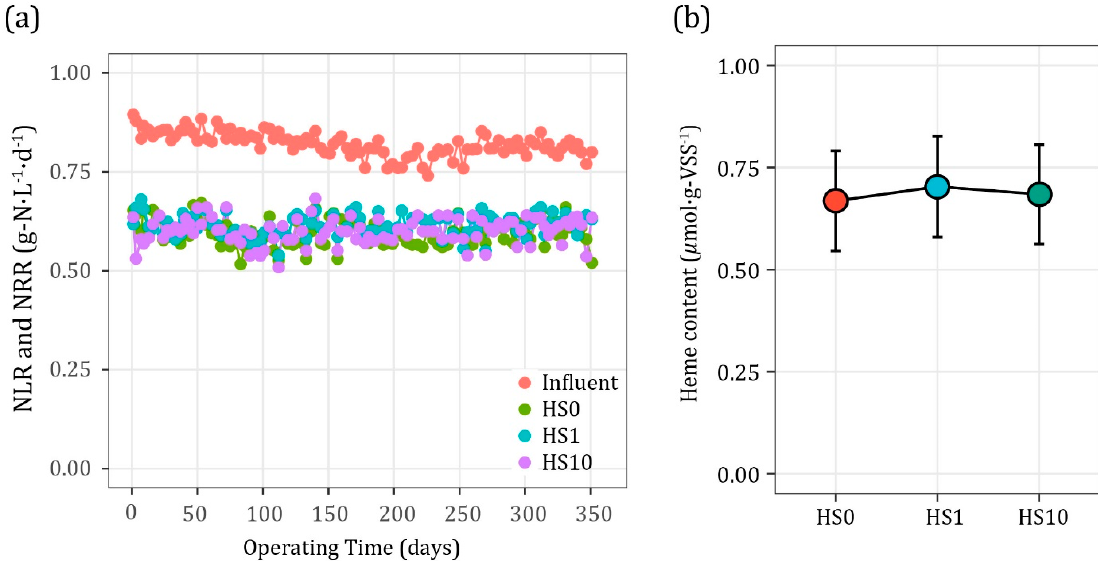
Figure 1. Reactor performance of anammox bioreactors and physiological dynamics of anammox bacteria under different humic substance concentrations. ( a ) Nitrogen loading rate (NLR) and nitrogen removal rate (NRR) during 351 days of operation. ( b ) Heme content. HS0, HS1, HS10 indicate 0, 1, 10 mg · L − 1 humic substances, respectively.